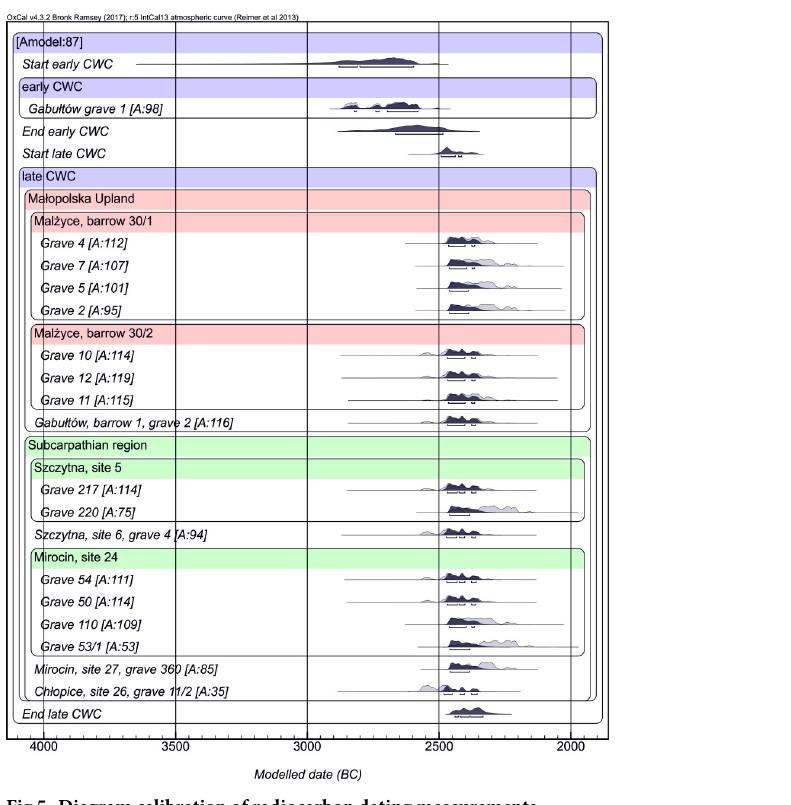
Fig 5. Diagram calibration of radiocarbon dating